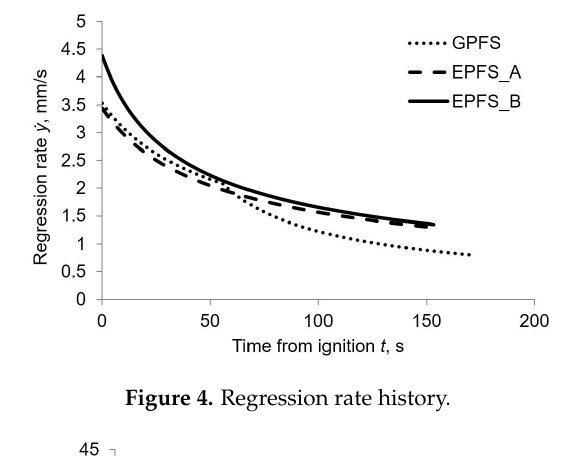
Figure 4. Regression rate history.